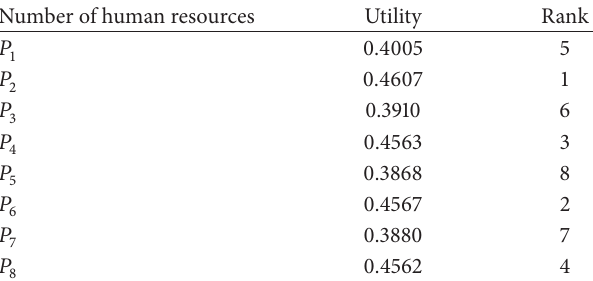
Table 6: Human resource ranking result. Number of human resources